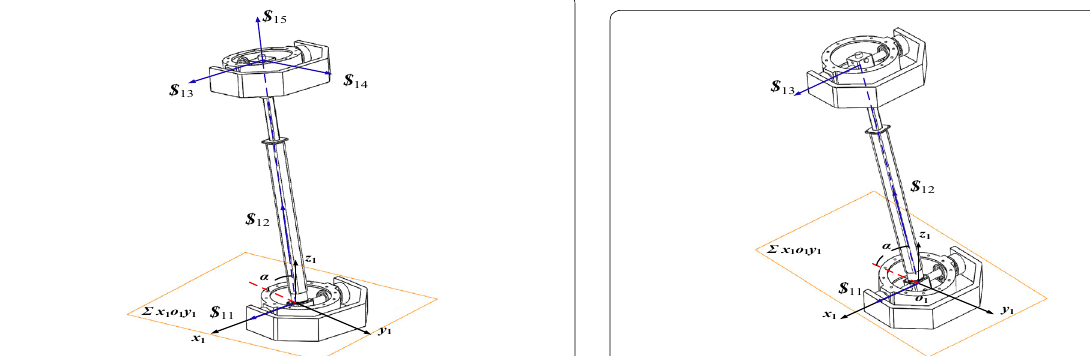
Figure 8. (rA-6)P(rA-1) limb Figure 9. (rA-6)P(rA-6)